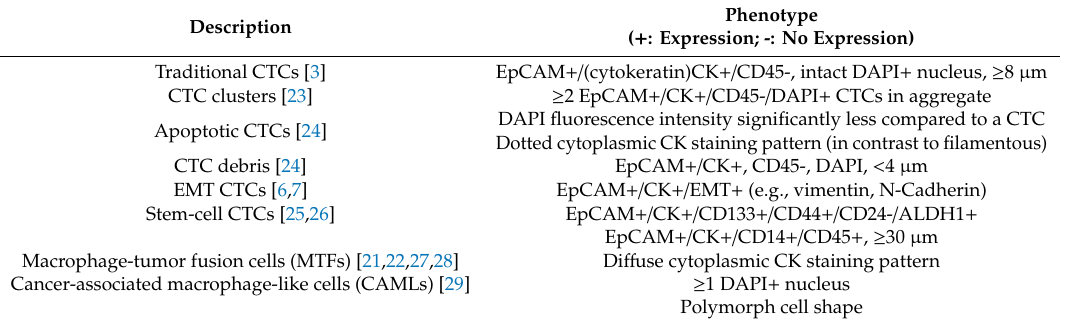
Table 1. Circulating, cancer-associated cell subtypes